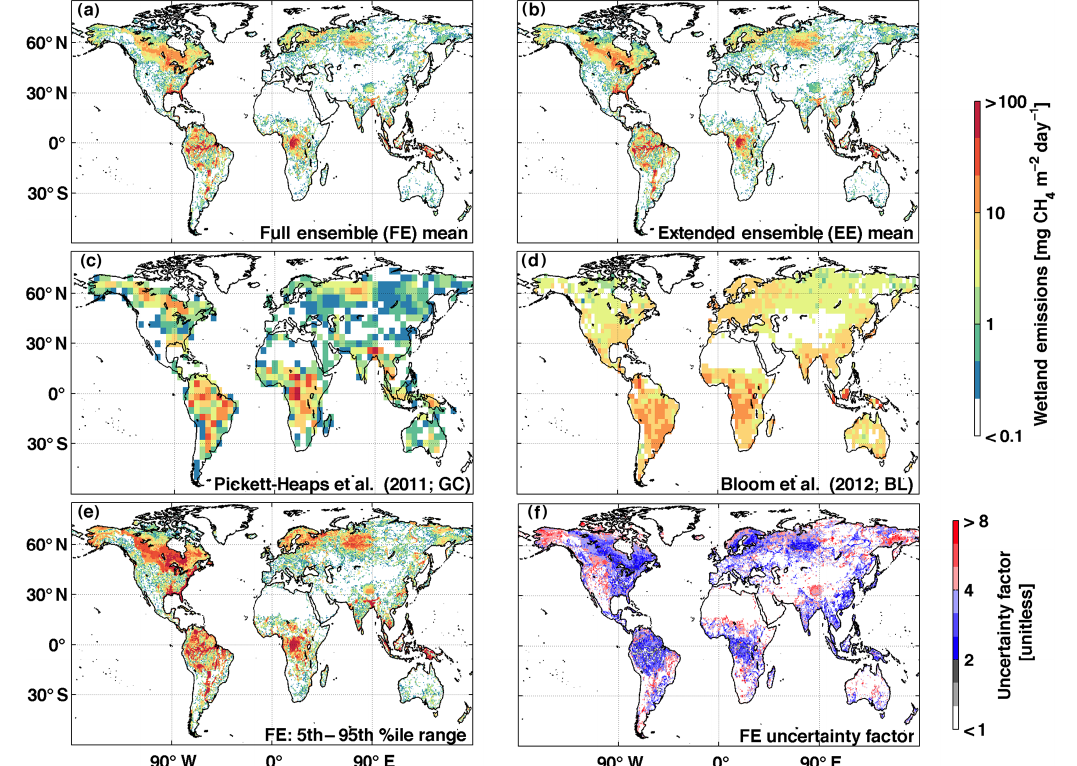
Figure 1. Top row (a, b) : 2009–2010 full model ensemble (FE; left) and extended model ensemble (EE; right) mean wetland CH 4 emis- sions. Middle row (c, d) : 2009–2010 emissions from the GEOS-Chem wetland CH 4 emissions inventory (GC; left) model and the satellite- constrained estimates by Bloom et al. (2012) (BL; right). Bottom row (e, f) : mean 2009–2010 FE 5th–95th percentile range (left) and uncertainty factor (5th–95th percentile range normalized by mean 2009–2010 emissions; right).